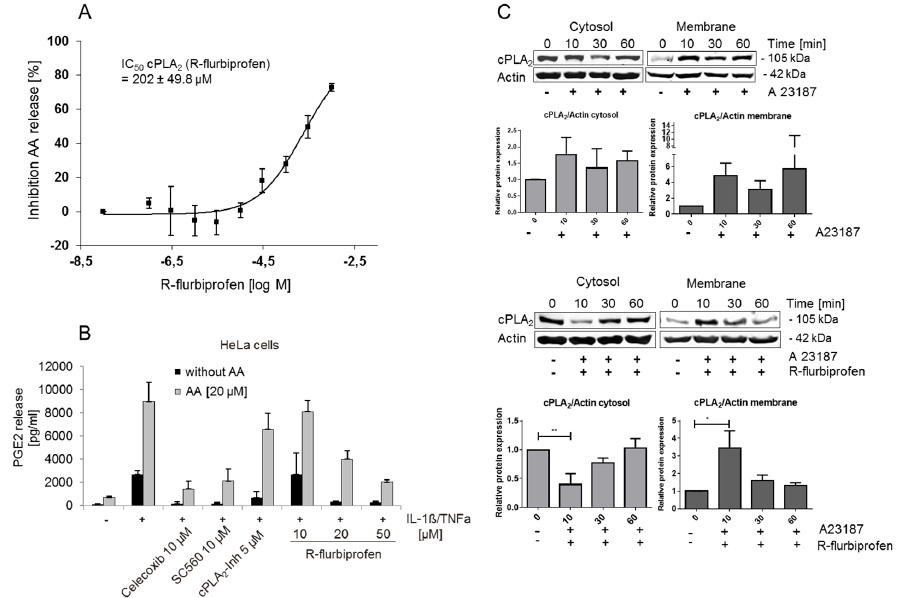
Figure 3. ( A ) cPLA 2 α activity assay: for the in vitro cPLA 2 α activity assay, small unilamellar